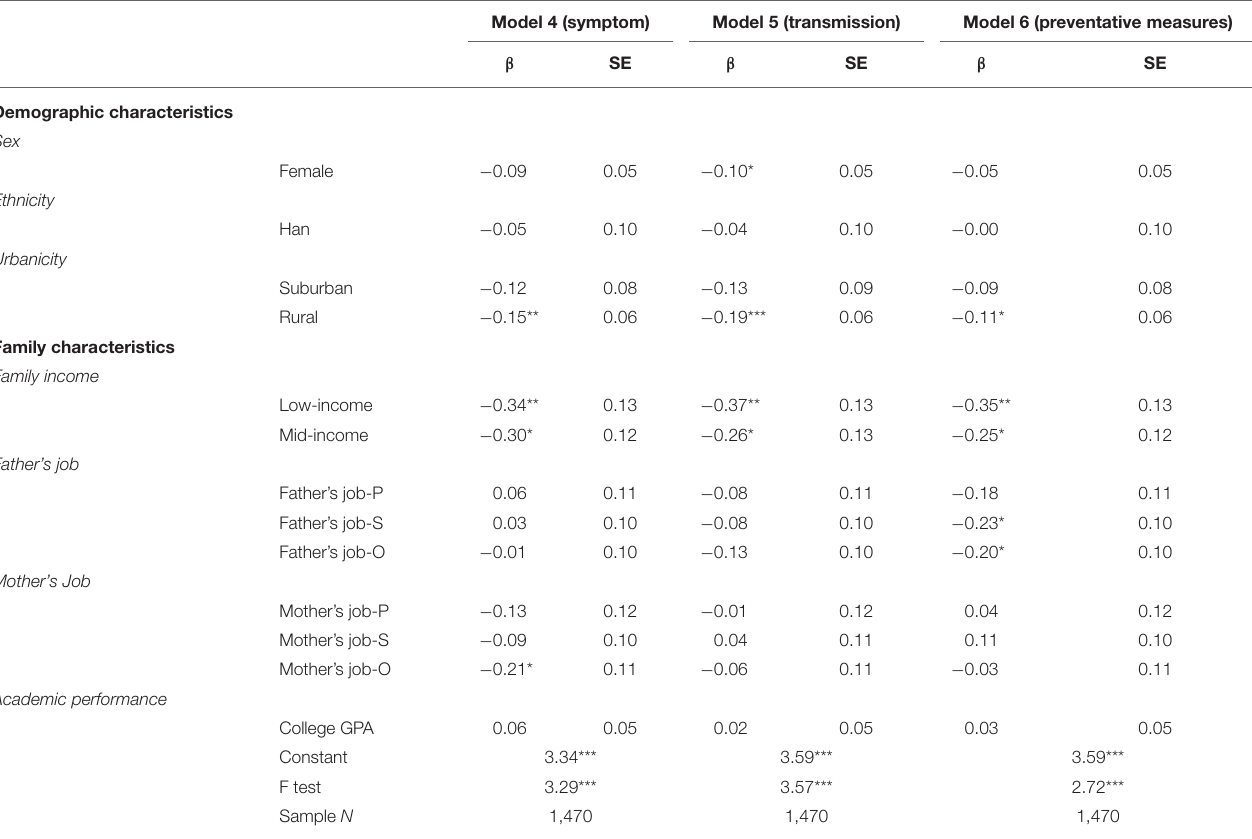
TABLE 4 | The relationships between family characteristics and students’ knowledge of